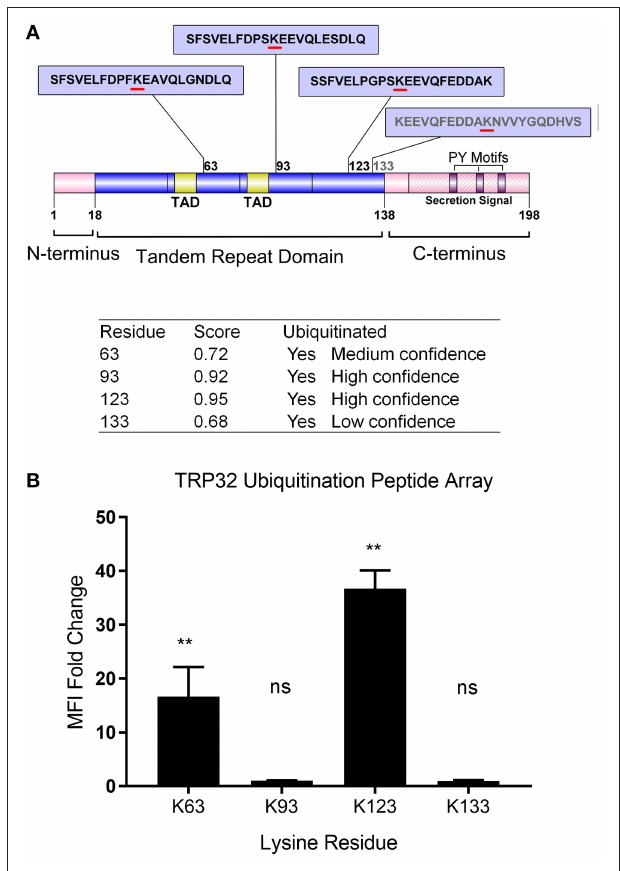
FIGURE 1 | Schematic of E. chaffeensis TRP32 domains and predicted sites of ubiquitination and in vitro ubiquitination of TRP32 lysine residues using a peptide array. (A) TRP32 contains four lysine residues, all of which are located within the tandem repeat domain and are predicted to be ubiquitinated with varying confidence levels. Proline-Tyrosine (PY) motifs: TPYY(165-168), NPYY(176-179), TPDY(185–188) are also shown. (B) TRP32 lysine containing peptides were tested in a microfluidic peptide ubiquitination assay. Lysine 63 and 123 showed significantly higher signals than corresponding peptides in which the lysine residues were substituted with